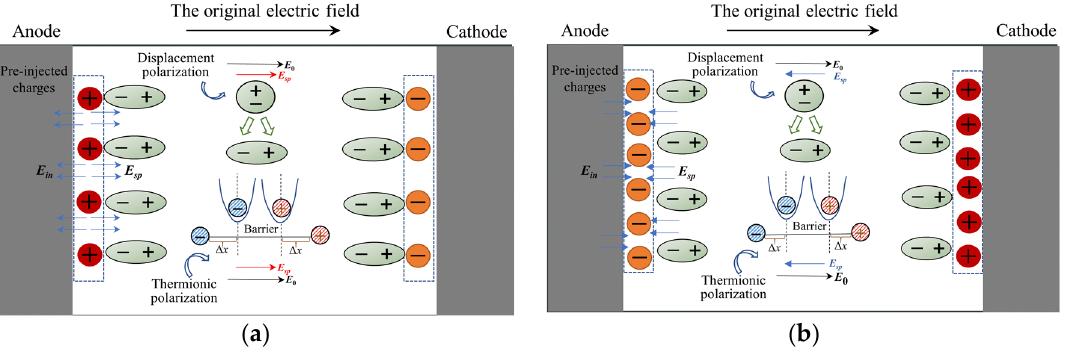
Figure 7. Schematic diagram of the effect of space charge on polarization processes. ( a ) the positive polarity pre-voltage; ( b ) the negative polarity pre-voltage.